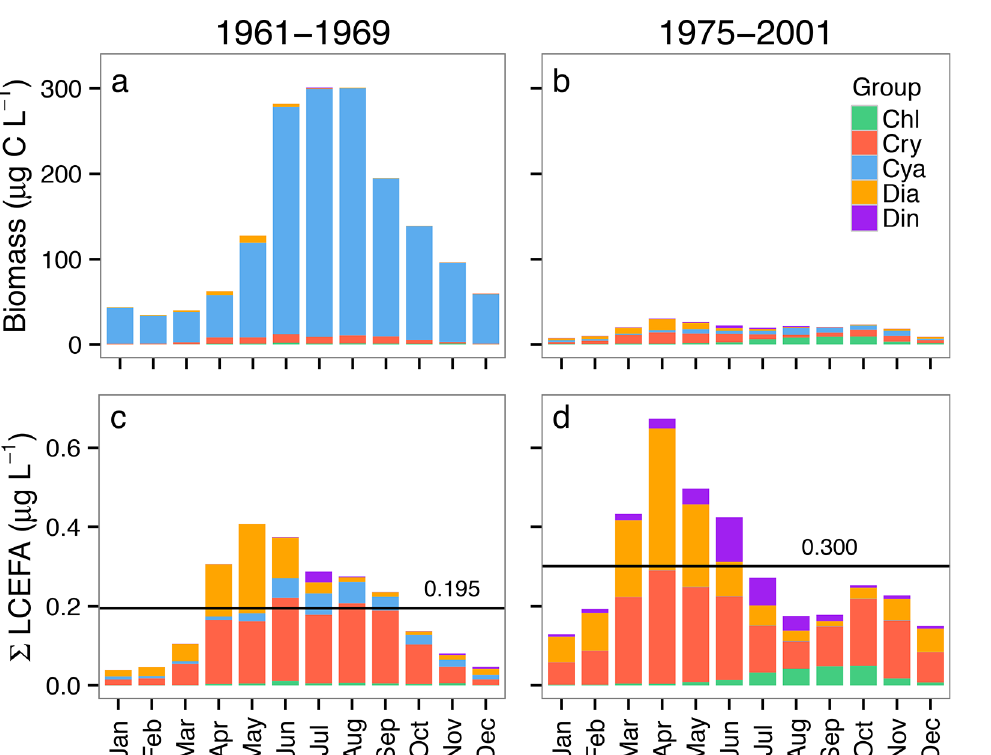
Fig 6. Stacked barplots of observed average monthly phytoplankton biomass (a, b) and calculated LCEFA concentrations (c, d) in Lake Washington. Panels (a) and (c) show the group composition during the eutrophic years (1961 – 1969), and panels (b) and (d) summarize the oligotrophic years (1975 – 2001) for biomass and LCEFA, respectively. Group specific LCEFA are calculated following Eq 2. The mean calculated annual LCEFA value across years within each time period is superimposed as a line on panels c and d. Abbreviations follow Fig 1.